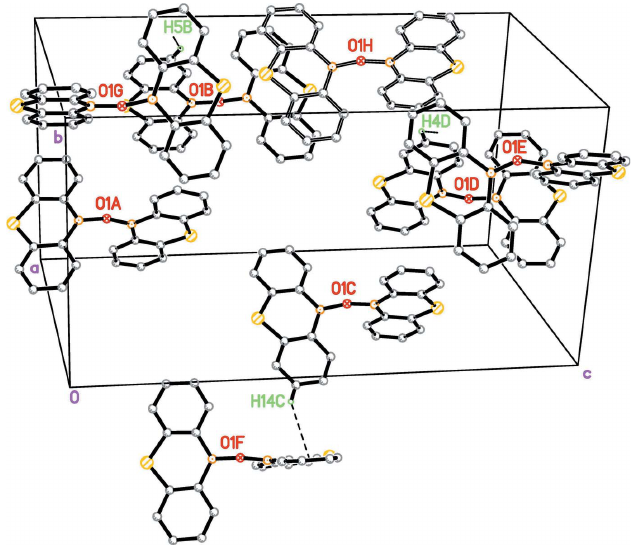
Figure 7 Partial packing diagram of (I). The molecules containing O1 A , O1 B , O1 C and O1 D are the four symmetry-independent molecules in the asymmetric unit. The molecule containing O1 E was generated by the symmetry operator 1 (cid:4) x , 1 + y , 1 (cid:4) z , that containing O1 F by the 2 symmetry operator 1 (cid:4) x , (cid:4) 1 + y , 1 (cid:4) z , that containing O1 G by the 2 symmetry operator 1 (cid:4) x , 1 + y , 1 (cid:4) z and that containing O1 H by the 2 symmetry operator x , 1 + y , z . This molecule is drawn with open bonds in order to show the (cid:2) – (cid:2) interaction. Only the H atoms involved in a C— H (cid:3)(cid:3)(cid:3) (cid:2) interaction are shown and labelled.